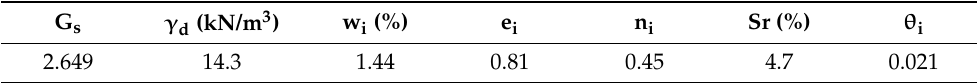
Table 2. Soil average initial state of PS after its setup in the